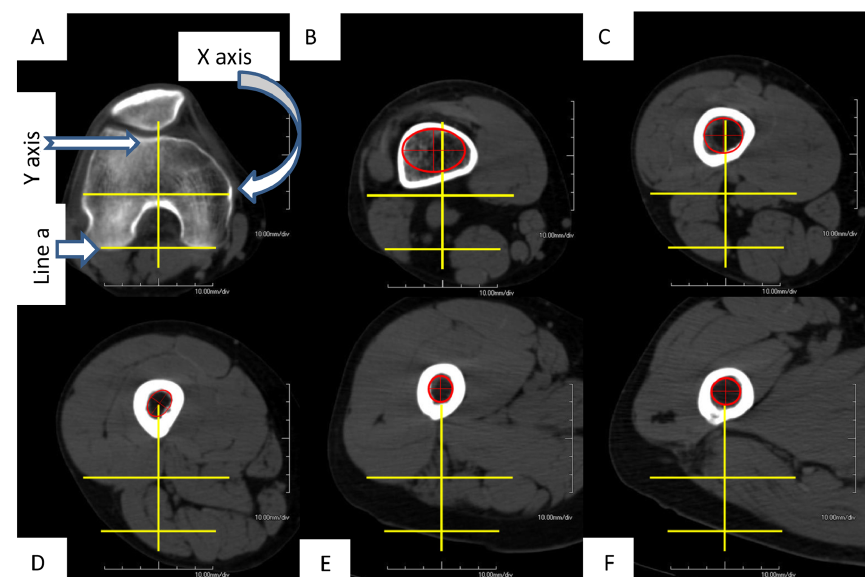
Figure 2. (A) Reference level, intersection between the widest intercondylar diameter and perpendicular line at the middle of both lines. The intersection point is Cartesian or coordinate point (0, 0), (B) center of the medullary canal is represented by the center of the red circle/ellipse best fitting the internal diameter of the medullary canal, (C)–(F) shows the movement of the instantaneous center of the medullary canal along the Y -axis (sagittal plane) and X -axis (coronal